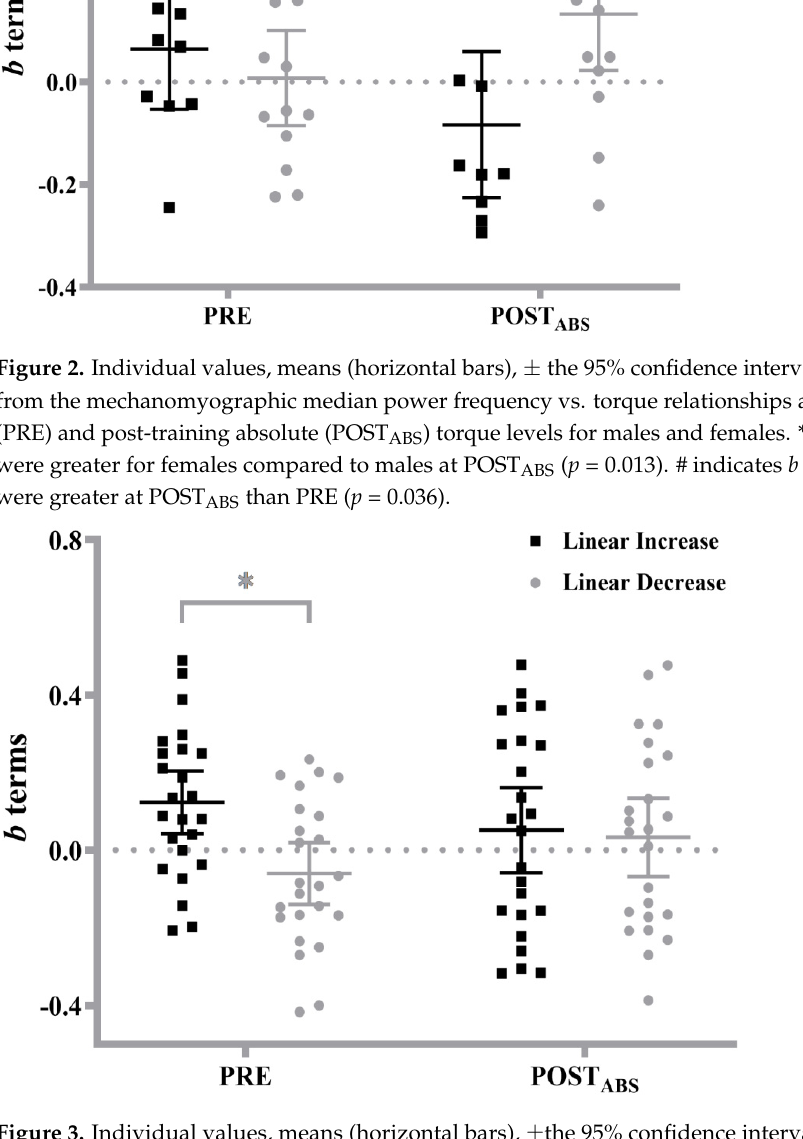
Figure 3. Individual values, means (horizontal bars), ± the 95% confidence intervals for the b terms from the mechanomyographic median power frequency vs. torque relationships for the linearly increasing and decreasing segment from the pre-training (PRE) and post-training absolute (POST ABS ) torque levels. * indicates greater b terms for the linearly increasing segment than the linearly decreasing segment at PRE ( p < 0.001). Table 1. Means, standard deviations (in parentheses), and 95% confidence interval (CI) ranges for the b terms calculated for the log-transformed mechanomyographic median power frequency– torque relationships during the pre-training (PRE) and post-training absolute (POST ABS ) torque lev- els for the males and females. Linearly Increasing Segment